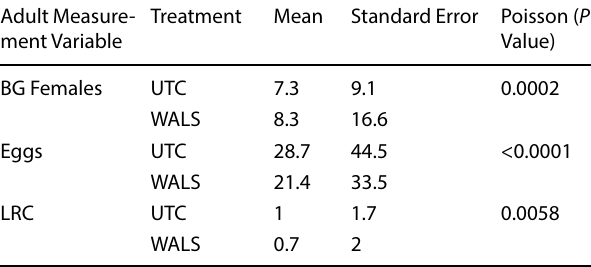
Table 1 Mean and standard deviation for all variables tested. The ‘Poisson’ column provides the p values for significance test compar- ing untreated control to WALS site for all variables tested